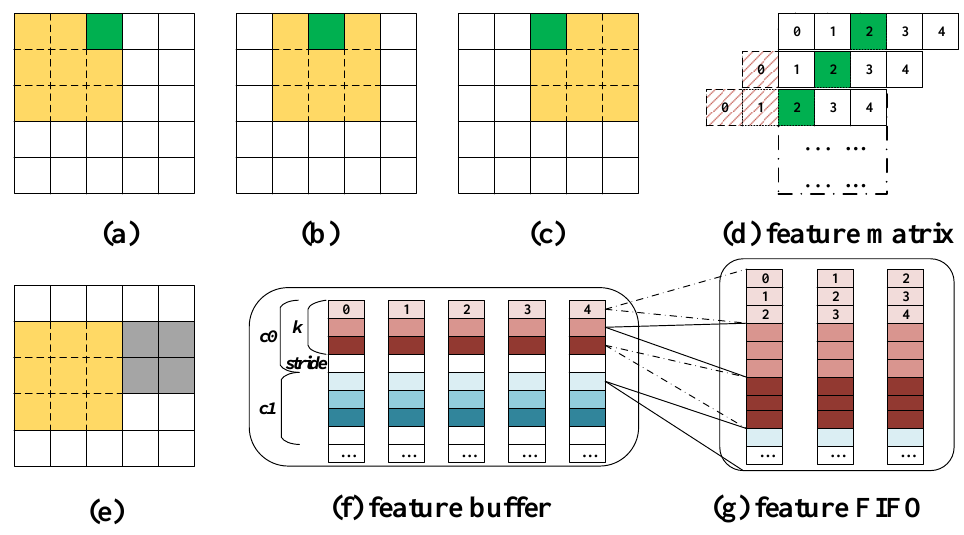
Figure 3. Generating feature matrix blocks in the matrix mapping